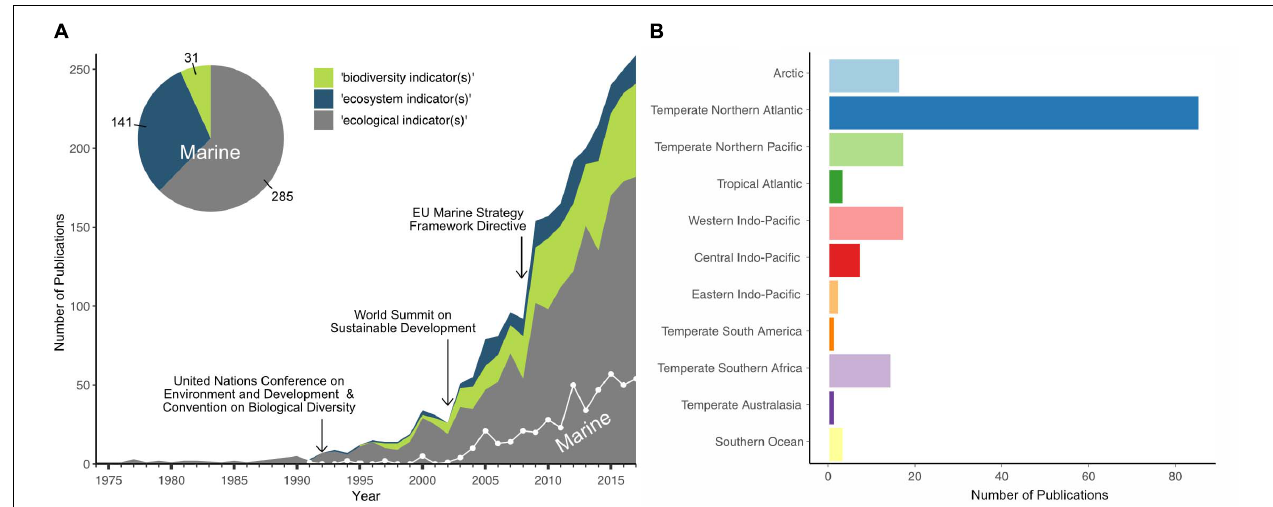
FIGURE 1 | Bibliographic analysis of publications on biodiversity, ecological, or ecosystem indicators in general and for marine systems specifically. (A) The number of publications using one of the indicator terms [biodiversity (green shading), ecosystem (blue shading), or ecological (gray shading) indicator(s)] between 1975 and 2017 (total of 2502), and the number of publications using these terms in relation to marine systems only (white trend line; total of 457), shown in relation to the years when three significant international or regional legislative frameworks were implemented. (B) The geographic distribution of a subset of 1430 publications across marine ecoregions (Spalding et al., 2007), extracted from publication abstracts and keywords. The bibliographic data were queried from the Web of Science database (accessed last Sept 18th, 2018).